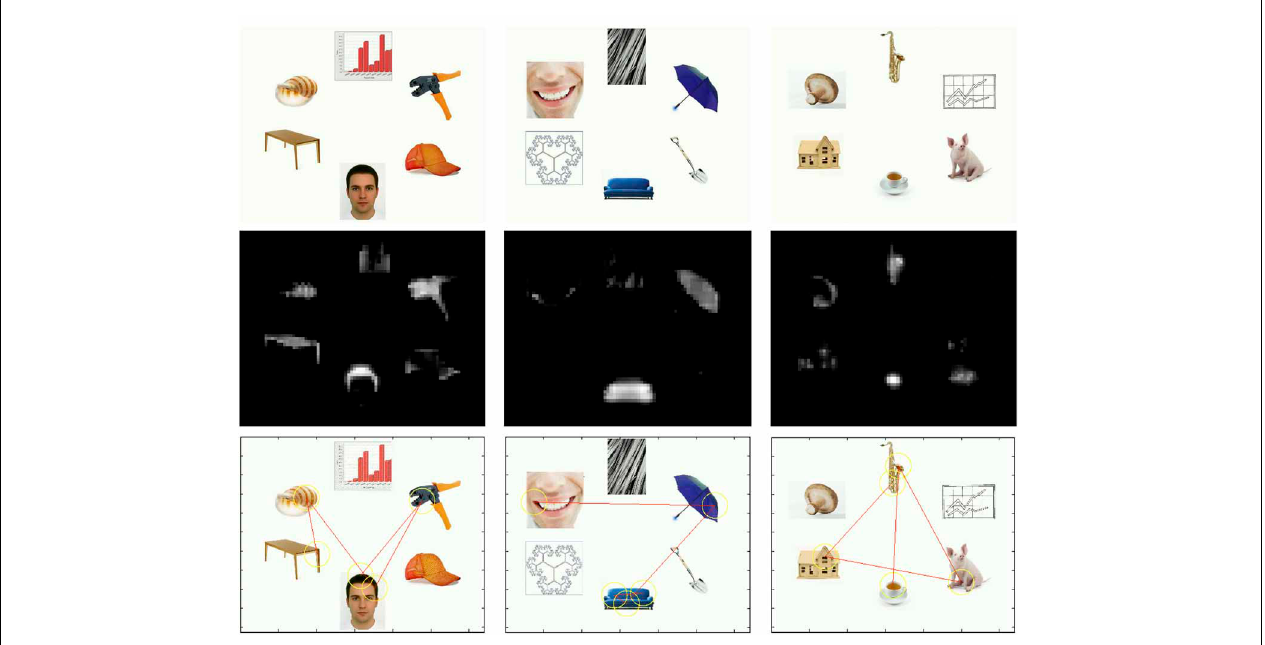
FIGURE 1 | Top row: Examples of stimulus arrays with a face (left), body part (center), or animal (right). Center row: Saliency maps of stimulus arrays in the top row. Bottom row: Modeled visual scanning based on saliency maps.